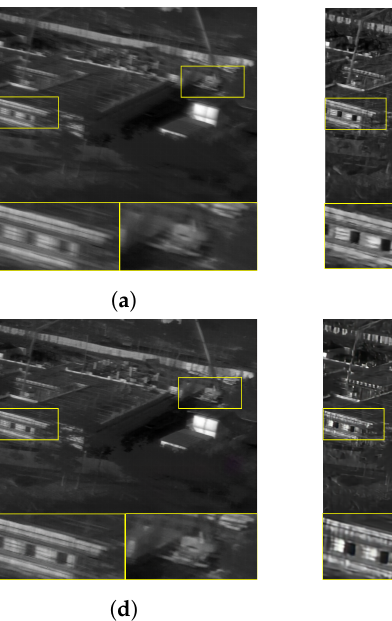
Figure 15. Qualitative comparison of motion deblurring results on the real blurry thermal image.